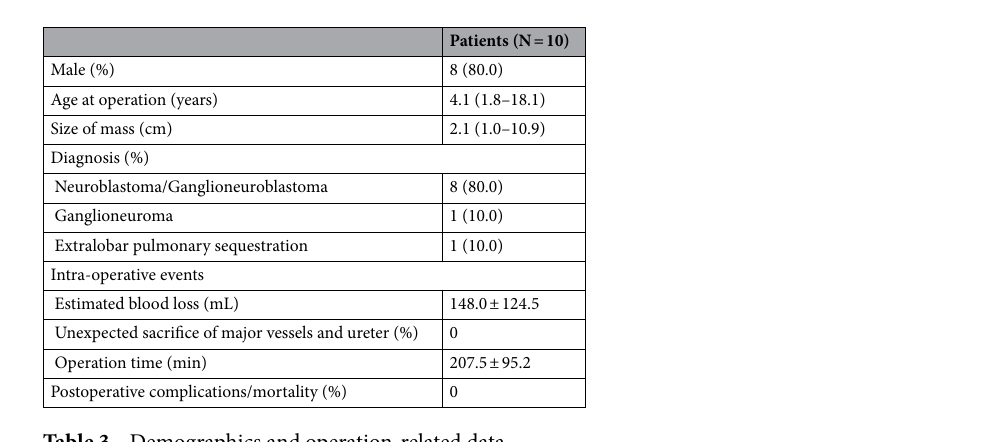
Table 3. Demographics and operation-related data.